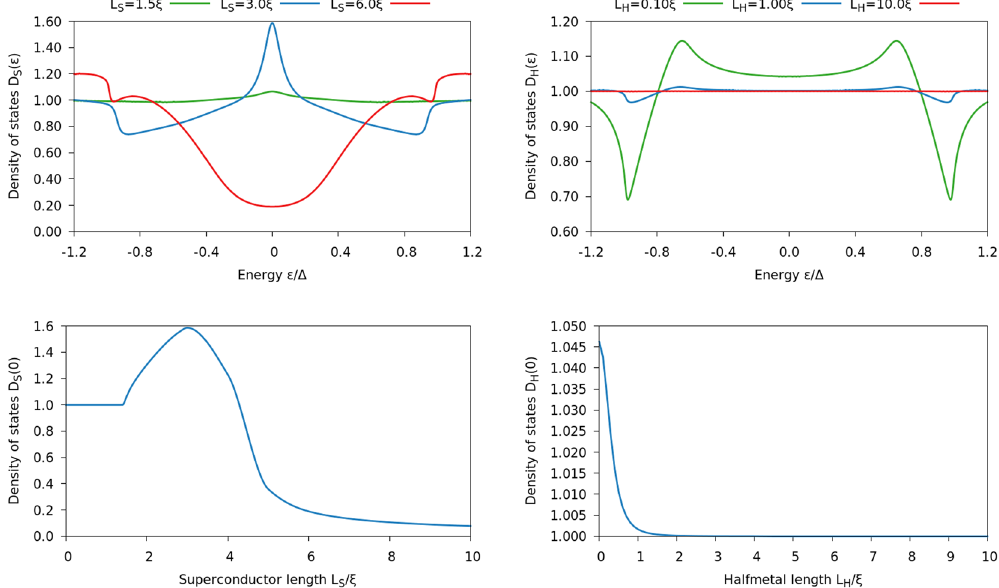
Figure 8. Plots of the DOS at an S/HM interface with G ϕ / G 0 = 10. The left plots show how the DOS D S on the superconducting side changes with the length L S of the superconductor, when we fix the halfmetal length L H = 10 ξ S . Conversely, the right plots show how the DOS D H on the halfmetallic side changes with L H when we set L H = 10 ξ S . The top plots display the energy dependence of the DOS, while the bottom plots highlight the zero-energy peak.